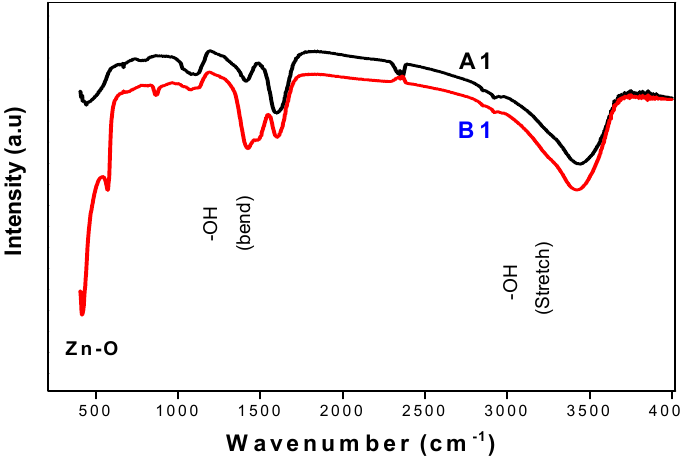
Figure 5. FT-IR spectra of A1 and B1 synthesized using S. persica leaf extract .